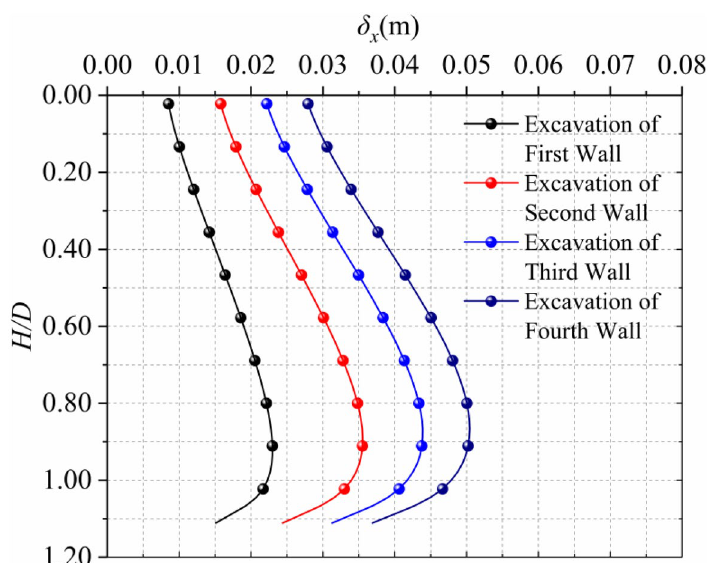
Figure 20. Horizontal displacement caused by multiple trench